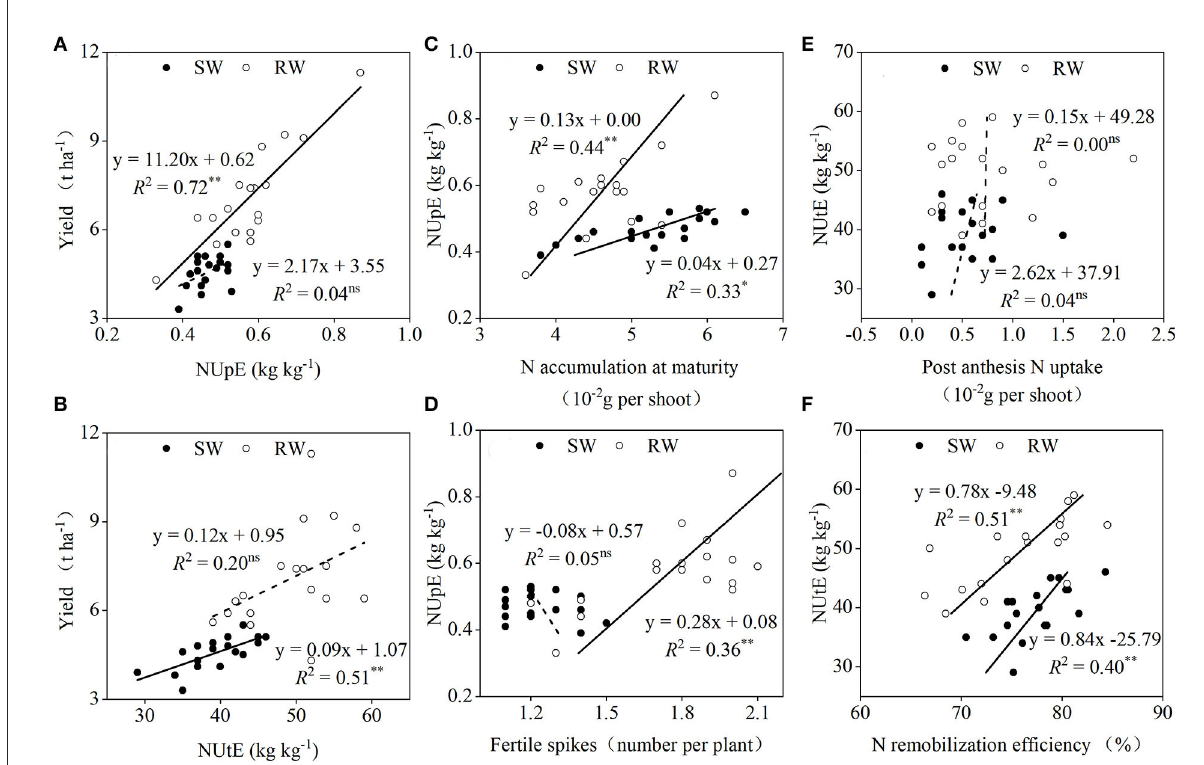
FIGURE5 Relationships between plant height and yield (A) , harvest index (B) ; between yield and harvest index (C) ; between N accumulation at anthesis and plant height (D) , days from sowing to flowering (E) , N accumulation rate (F) in two wheat cropping systems. All values were measured with three replications ( n = 3), two-year data were pooled. SW, soybean-wheat cropping system; RW, rice-wheat cropping system; N, nitrogen. ns represents non-significant at P > 0.05, while * and ** represent significant at P < 0.05 and P < 0.01 from ANOVA, respectively. Solid and dashed lines indicate significant and insignificant differences at P < 0.05 and P > 0.05,